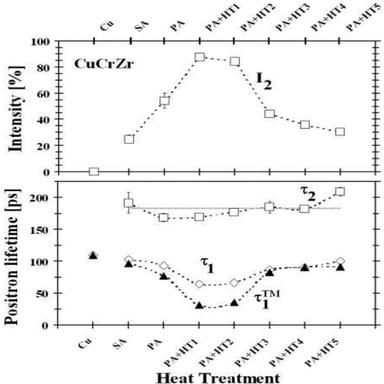
The experimental PAS values (intensity I2 and lifetimes τ 1, τ 2) for non-irradiated CuCrZr alloy samples in comparison to value for pure Cu (110 ps \). The positron lifetime components: τ 1 – shortest lifetime, τ 2 – long defect lifetime, τ 1 TM – calculated τ 1 value derived from the trapping model by Eq.